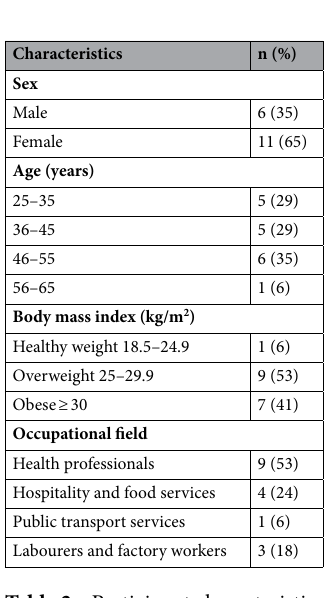
Table 2. Participant